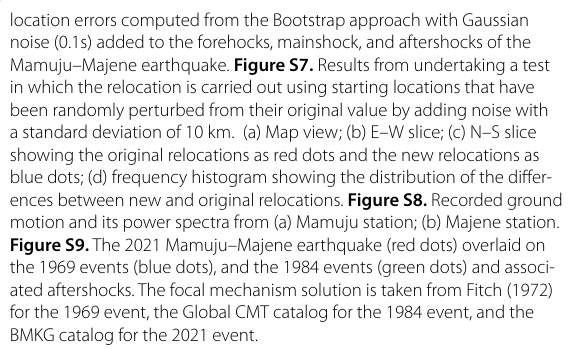
Figure S9. The 2021 Mamuju–Majene earthquake (red dots) overlaid on the 1969 events (blue dots), and the 1984 events (green dots) and associ- ated aftershocks. The focal mechanism solution is taken from Fitch (1972) for the 1969 event, the Global CMT catalog for the 1984 event, and the BMKG catalog for the 2021